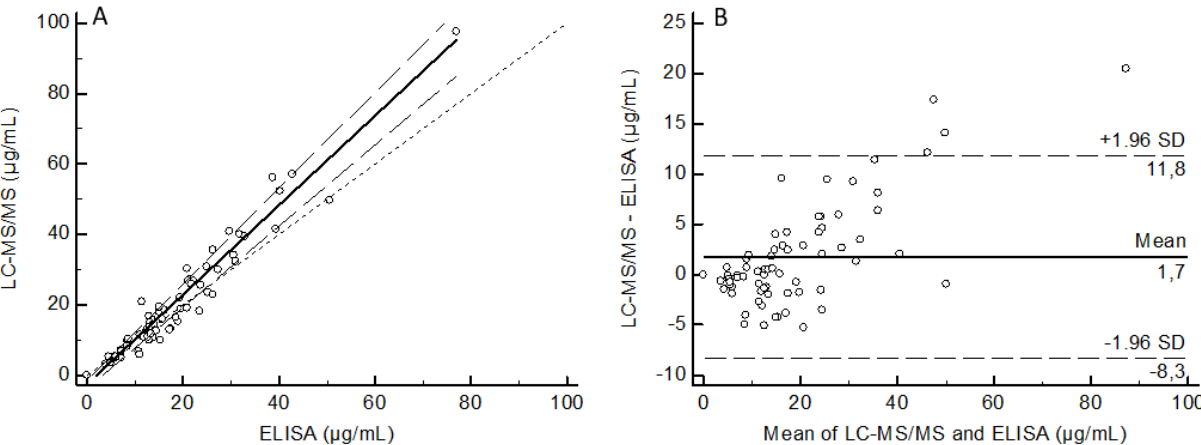
Figure 7. Analysis of 70 patient samples with LC-MS/HRMS and ELISA. Passing-Bablok regression ( A ) and Bland-Altman ( B ) analysis between the LC-MS/HRMS method and the ELISA method. For the Passing-Bablok analysis, the solid and dashed lines indicate the regression line and confidence interval for the regression line, respectively. For the Bland-Altman analysis, the solid line indicates the mean difference between the